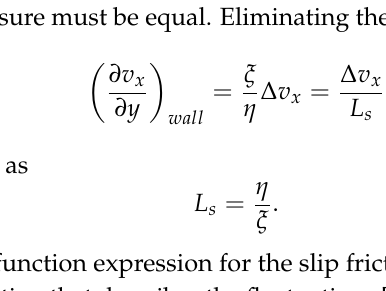
0 because we assume flow between −